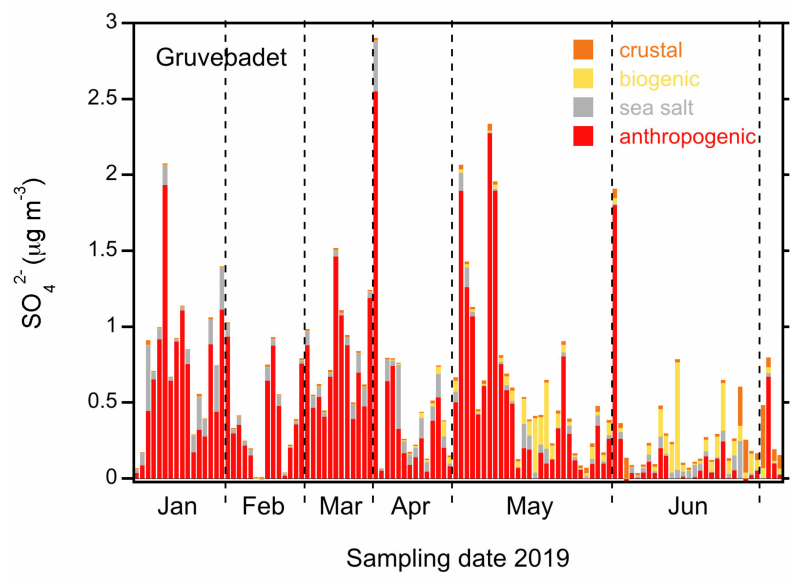
Figure 14. Source apportionment of SO 2 −